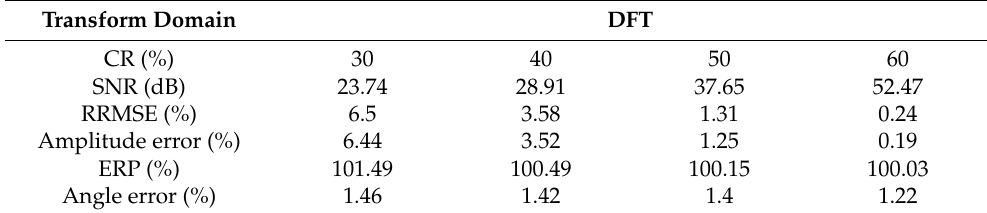
Table 1. Reconstruction results of harmonic signals in the DFT domain.